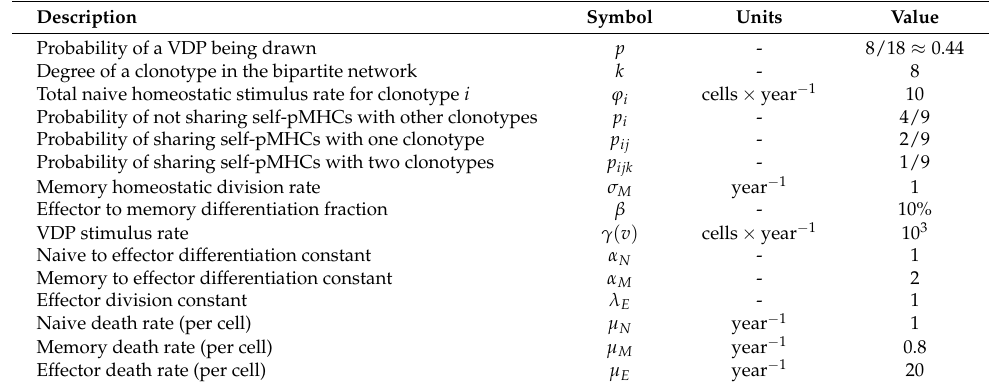
Table 2. Parameter values to simulate the dynamics of three T cell clonotypes for a period of one year. Description